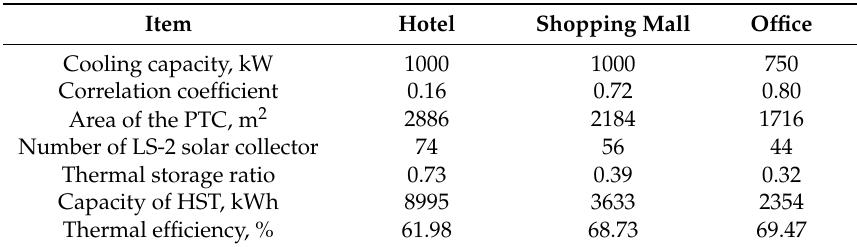
Figure 11. Hourly cooling loads for different buildings. Table 6. Performance comparisons of solar cooling systems in different buildings. HST—heat storage